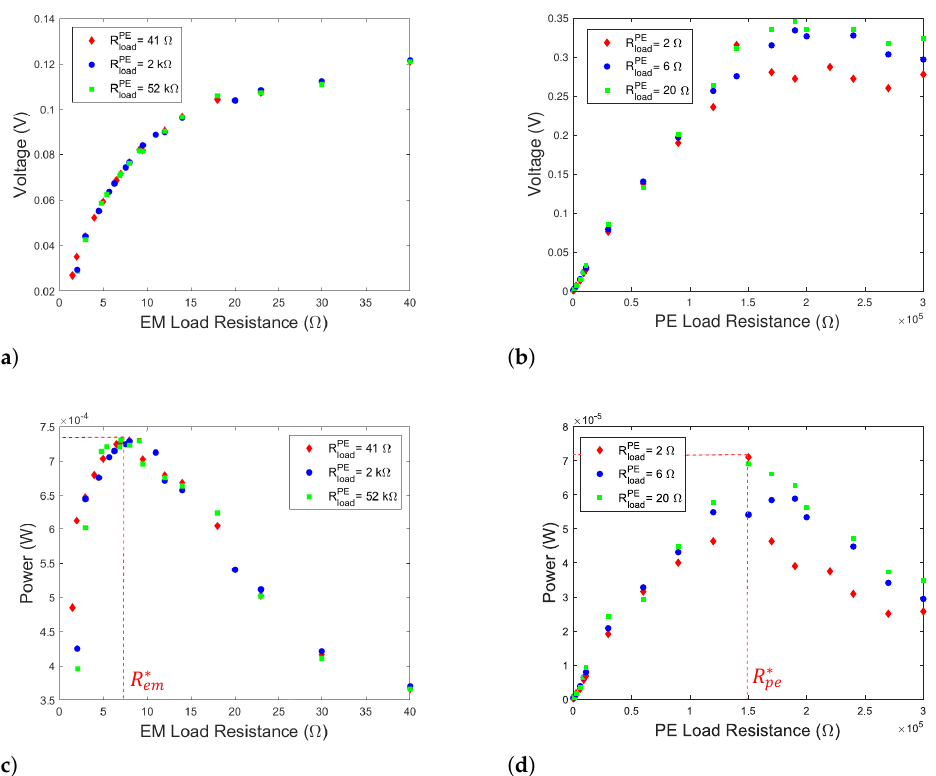
Figure 3. ( a ) Voltage of the bottom EM elements versus the PE load resistances; ( b ) voltage of the PE elements versus the EM load resistances; ( c ) harvested power from the EM elements; ( d ) harvesting power from the PE elements.